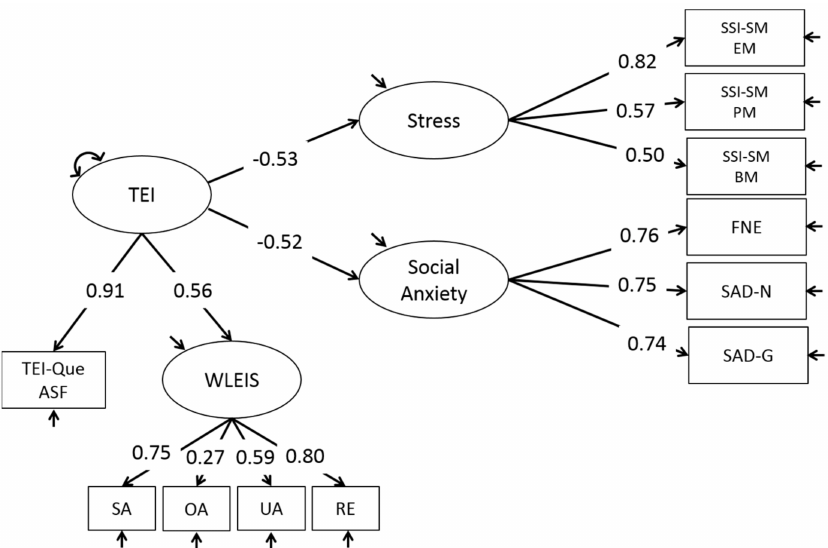
Figure 2. Structural equations model with standardized estimated parameters for the variables TEI, social anxiety, and stress. TEI = Trait Emotional Intelligence; TEIQue-ASF = Trait Emotional Intelligence Questionnaire Adolescents Short Form; WLEIS = Wong and Law´s Emotional Intelligence Scale; SA = appraisal and expression of emotion in the self; OA = appraisal and recognition of emotion in others; UA = use of emotions or assimilation; RE = regulation of emotions in the self; SSI-SM = Student Stress Inventory-Stress Manifestations; EM = Emotional Manifestations; PM = Physiological Manifestations; BM = Behavioral Manifestations; FNE = Fear of Negative Evaluation; SAD-N = Social Avoidance Distress-New; SAD-G = General Social Avoidance and